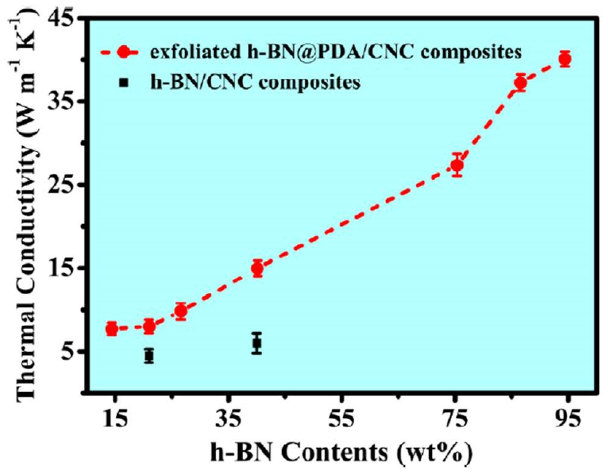
Figure 13. Thermal conductivity of exfoliated h-BN@PDA/CNC composite and h-BN/CNC compo- sites [103]. (RightsLink License obtained to use this Figure from CCC, Copyright Clearance Center, ACS Publishers, ACS Applied Nanomaterials).